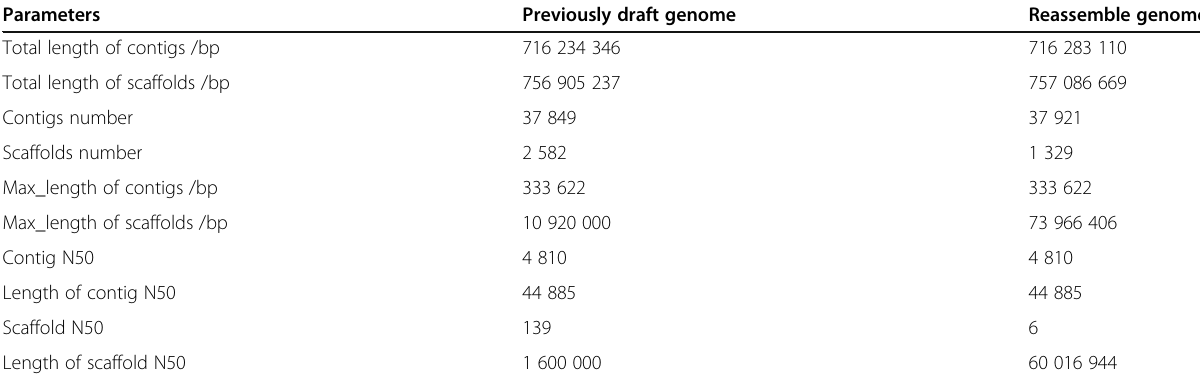
Table 2 The statistics of the draft genome and the reassembled G. raimondii genome Parameters